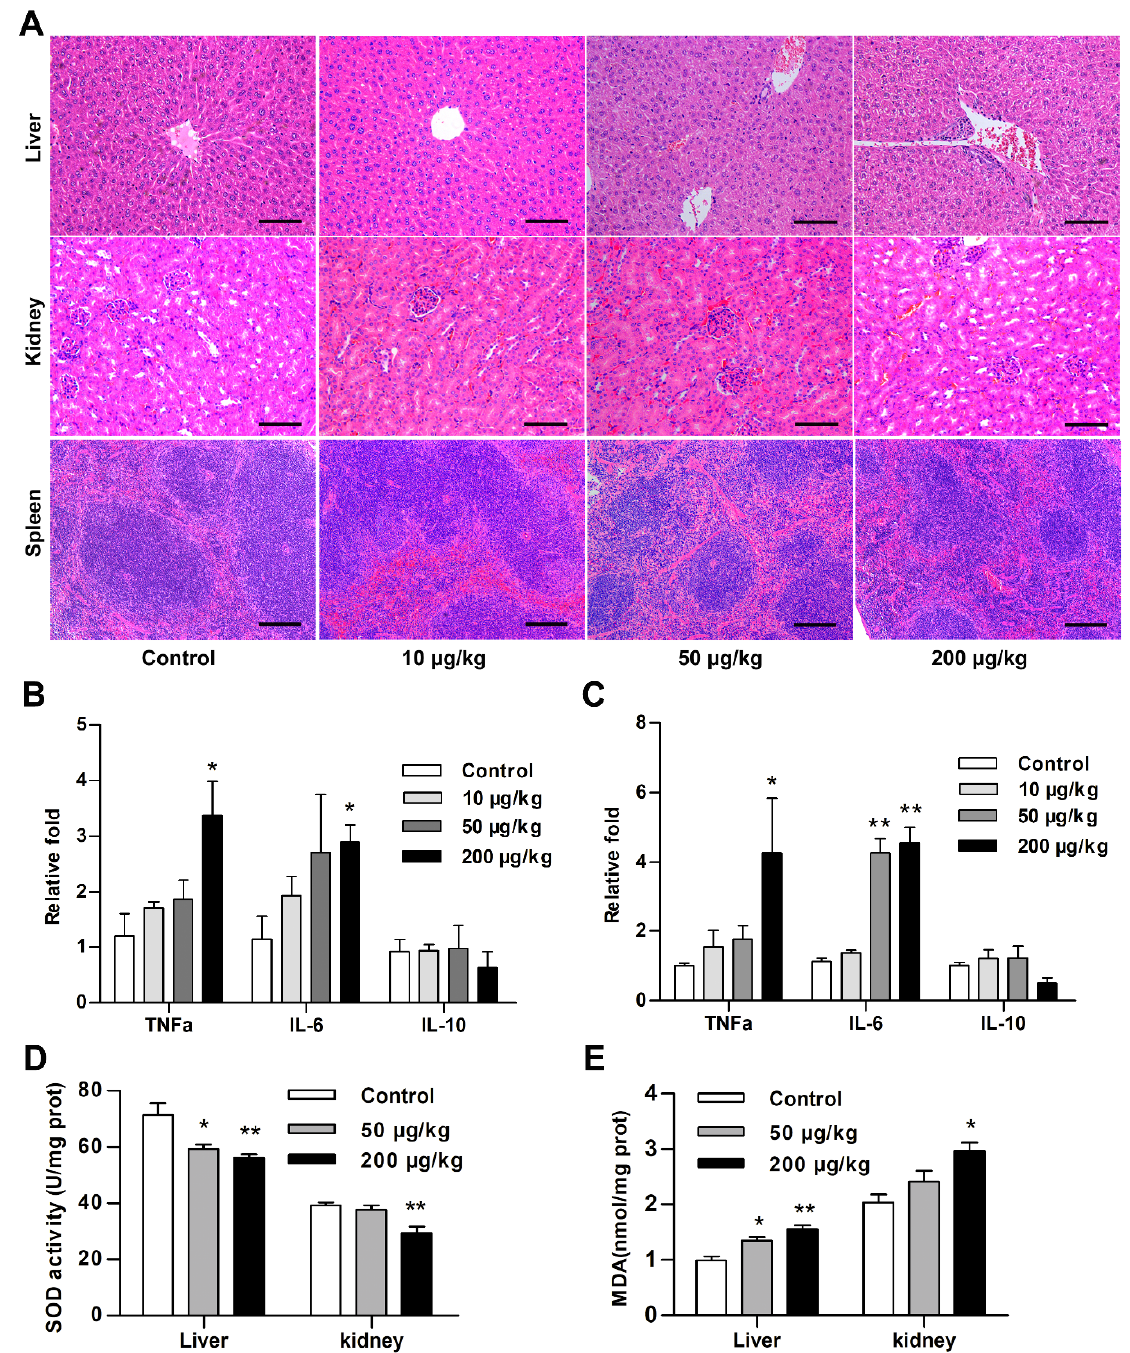
Figure 1. Cereulide exposure induces the oxidative stress production and the expression alteration of inflammatory cytokine. ( A ) Representative images of mouse liver, kidney and spleen tissues stained with H&E. Image magnification: ×200; scale bar = 100 µ m. ( B , C ) The mRNA levels of TNF- α , IL-6 and IL-10 were detected in liver and kidney tissues by RT-qPCR. Data are shown as the mean ± SD ( n = 5). ( D , E ) SOD activity and MDA levels in liver and kidney tissues exposed to different concentrations of cereulide ( n = 5). For all panels, * p < 0.05, ** p < 0.01 compared to the control group.